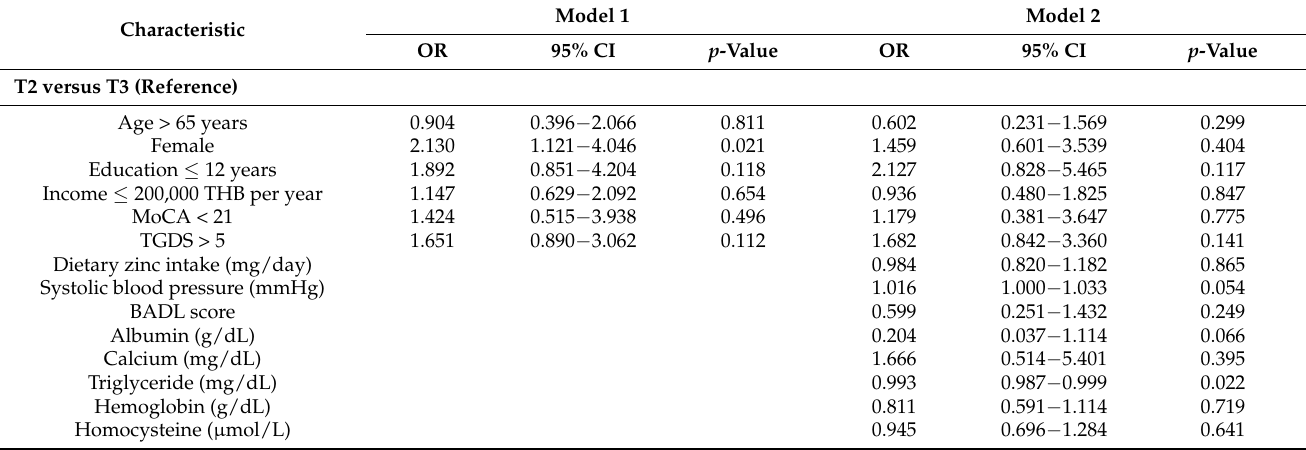
Table 5. Multivariate multinomial logistic regression analysis results (serum zinc levels in T2 vs.